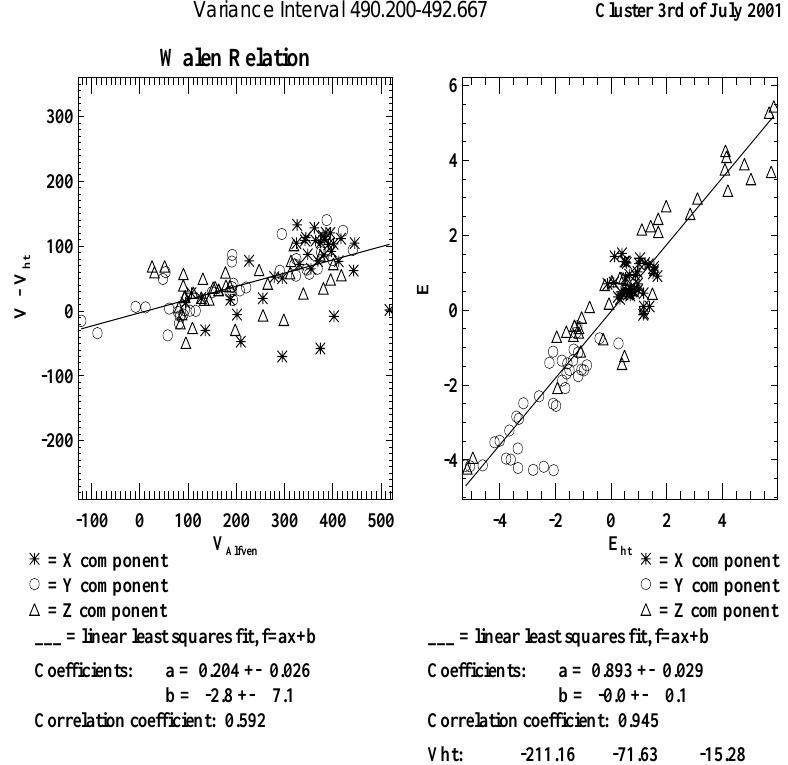
Fig. 17. Wal´en relation (left) and deHoffmann-Teller frame (right) between 08:10:12–08:12:45 UT determined from sc3 measurements.